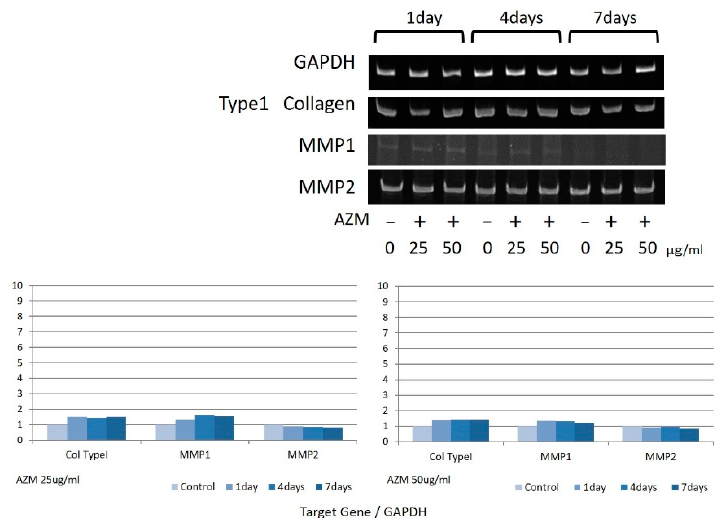
Figure 11. Gene expression of Type I-Collagen, MMP-1, and MMP-2 in hPLFs due to the influence of AZM. The most representative data were shown.